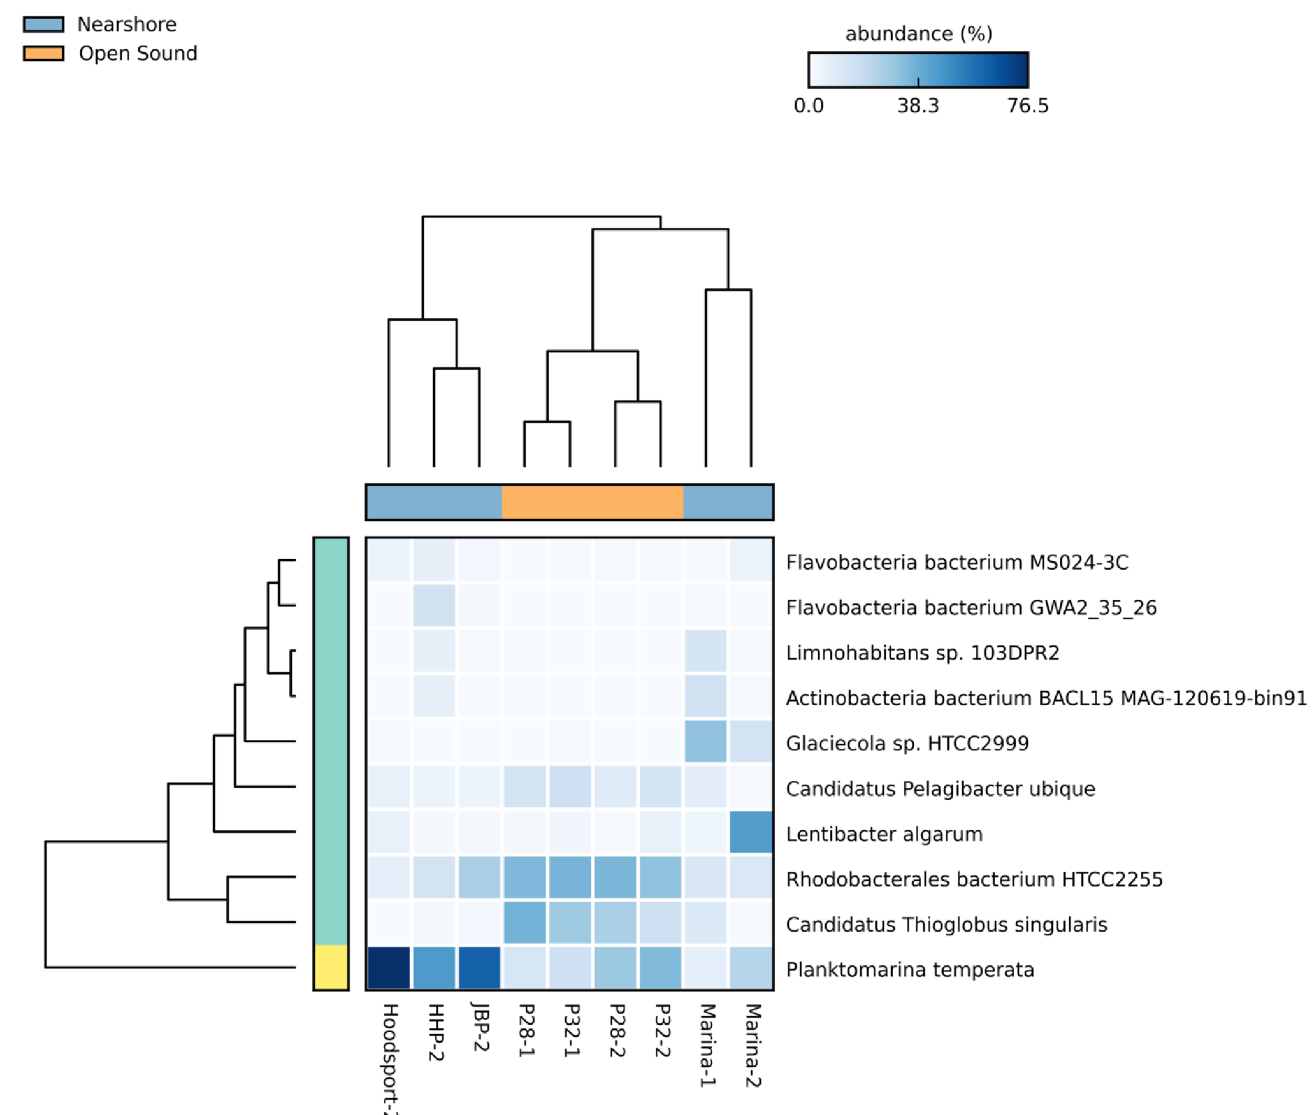
Fig 4. Relative abundances for the 10 most common bacterial species in 5 nearshore and 4 open sound samples. Increasing taxonomic abundance is indicated by darker blue boxes. Nearshore samples (blue bar) clustered by sampling season and open sound samples (orange bar) clustered by sampling location over different sampling